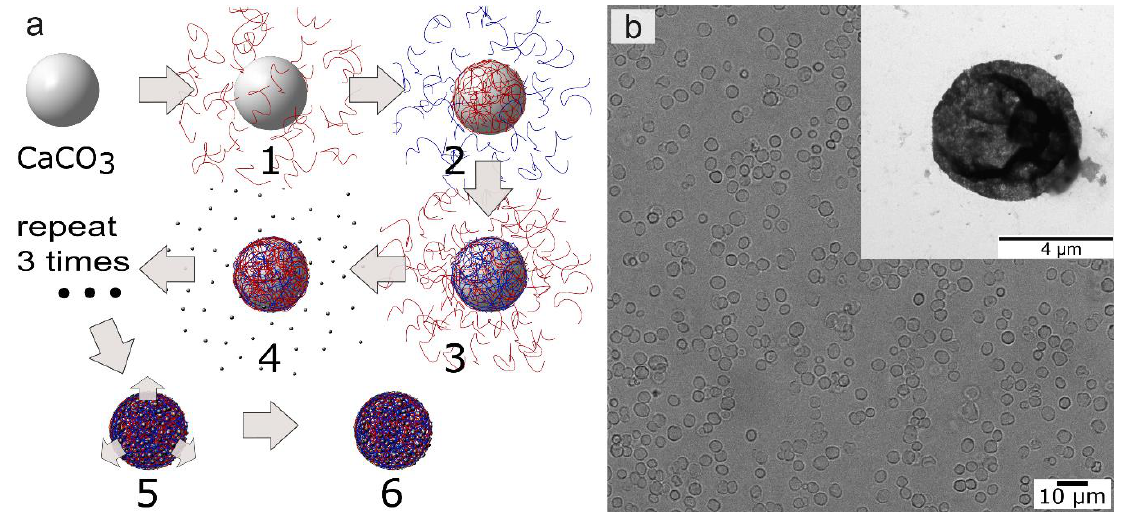
Figure 1. ( a ) Scheme of microcapsule preparation: 1, 3 – adsorption of Parg, 2 – adsorption of Dex, 4 – adsorption of magnetite nanoparticles (MNP)s, 5 – dissolution of core, 6 – magnetic polyelectrolite microcapsule. ( b ) Optical and transmission electron microscopy (TEM) (inset figure) images of biodegradable microcapsules containing magnetite MNPs.